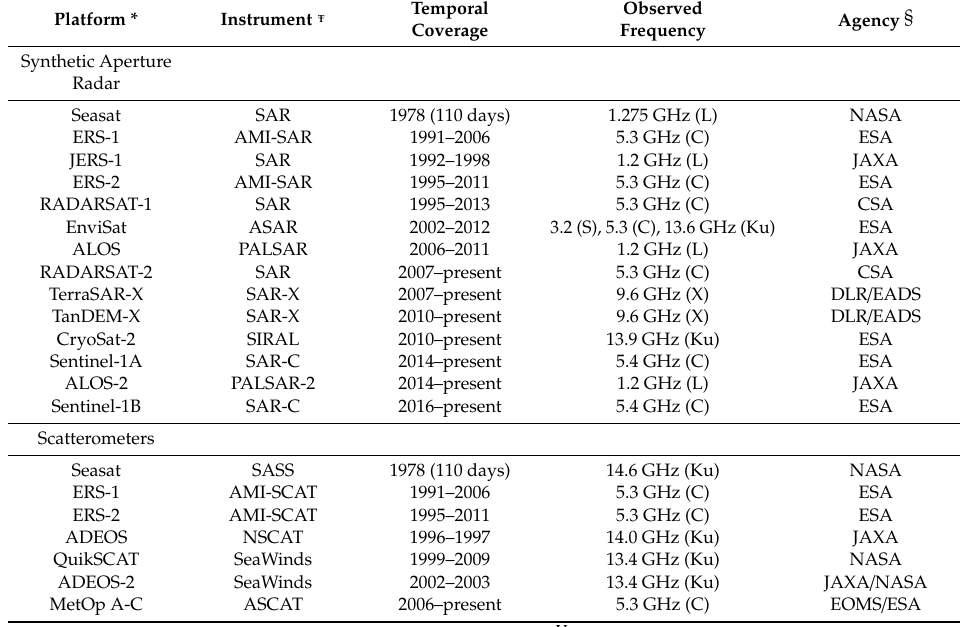
Managing agencies are identified by the WMO